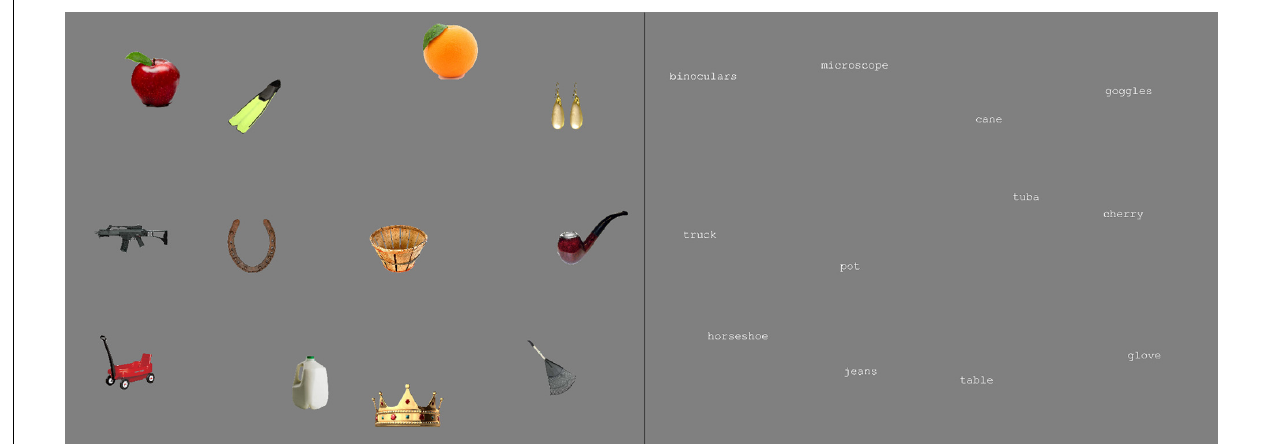
FIGURE 1 | Examples of the arrays used in the